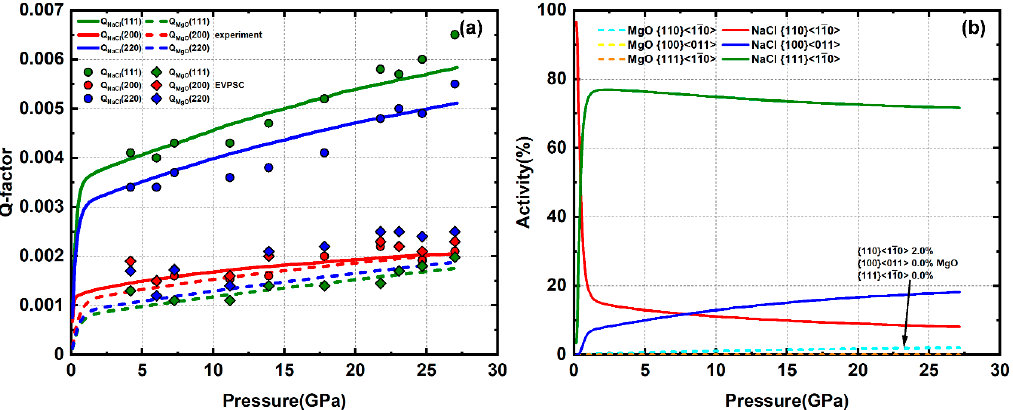
Figure 8. ( a ) Experimental and modeled Q-factors of 30% MgO + 70% NaCl. ( b ) slip system activity of MgO and NaCl.